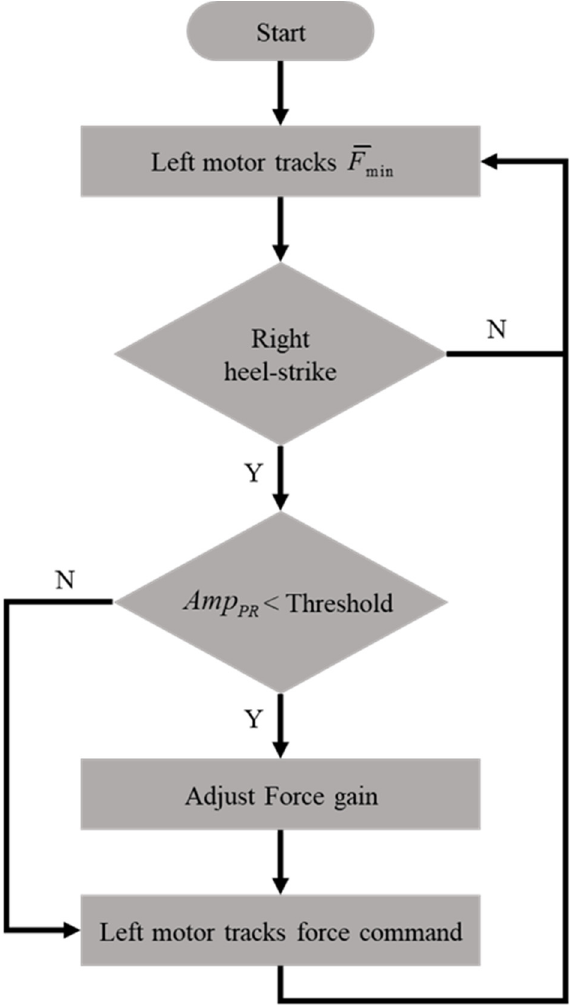
Figure 7. The modified intervention method (on the non-paretic side).